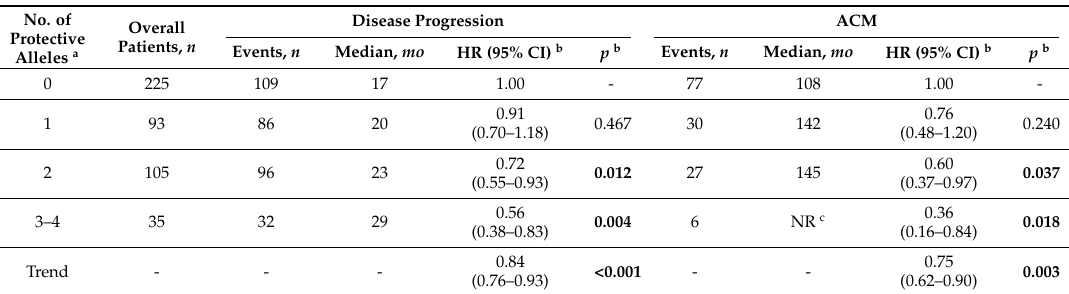
Table 3. Cumulative effect of predictive markers on disease progression and ACM in prostate cancer patients treated with ADT.